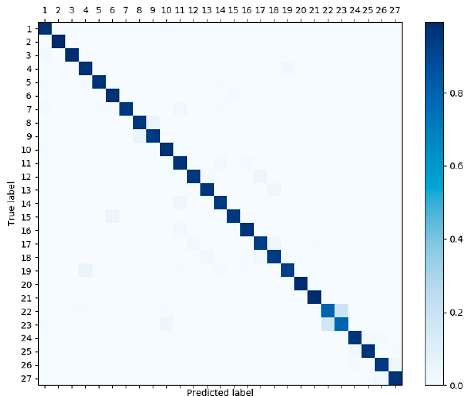
Figure 9. Confusion matrix created by MEST.